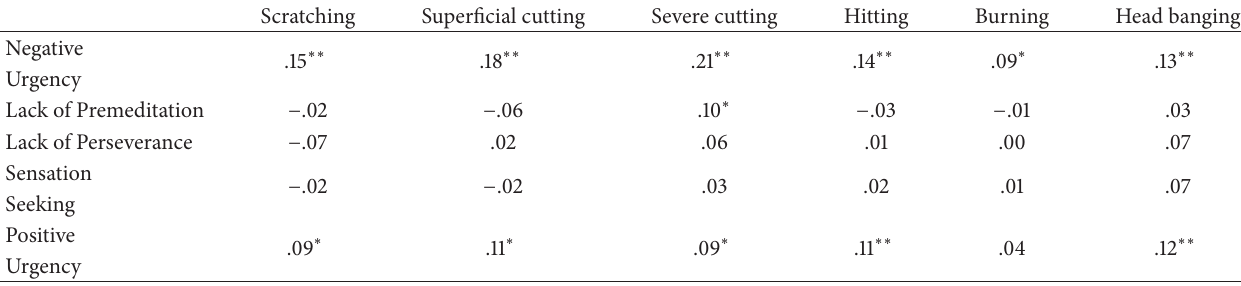
Table 1: Spearman’s rank correlations between the UPPS-P impulsivity dimensions and the presence/absence of different NSSI methods ( N = 613).